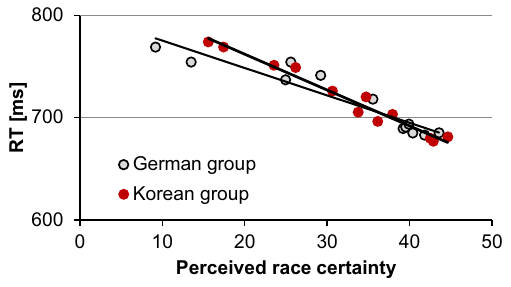
Figure 4. Relation between perceived race certainty calculated for each face types of both ethnicities together and response times for each participant group. Black lines: linear